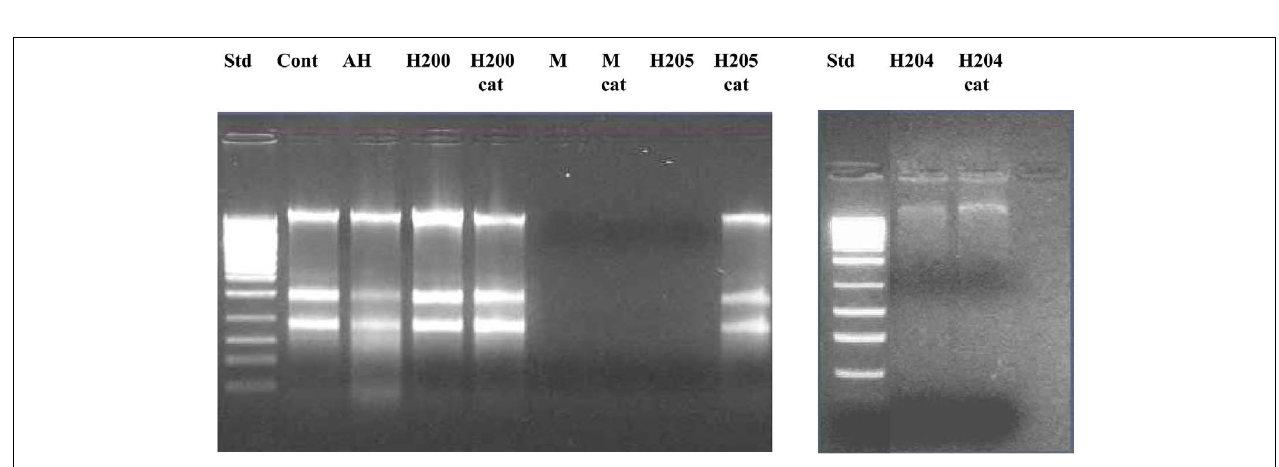
FIGURE 4 | Effect of exposure of E. coli cultures to honey or exogenous hydrogen peroxide on the integrity of bacterial DNA .The cells were treated with honeys (manuka, buckwheat honeys H203, H204, and H205) or